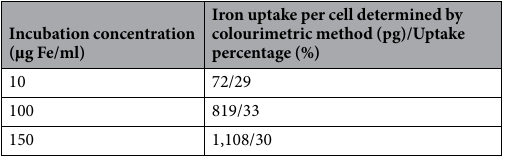
Table 1. Quantification of cellular uptake of IONPs by hMSCs determined by the colou rimetric